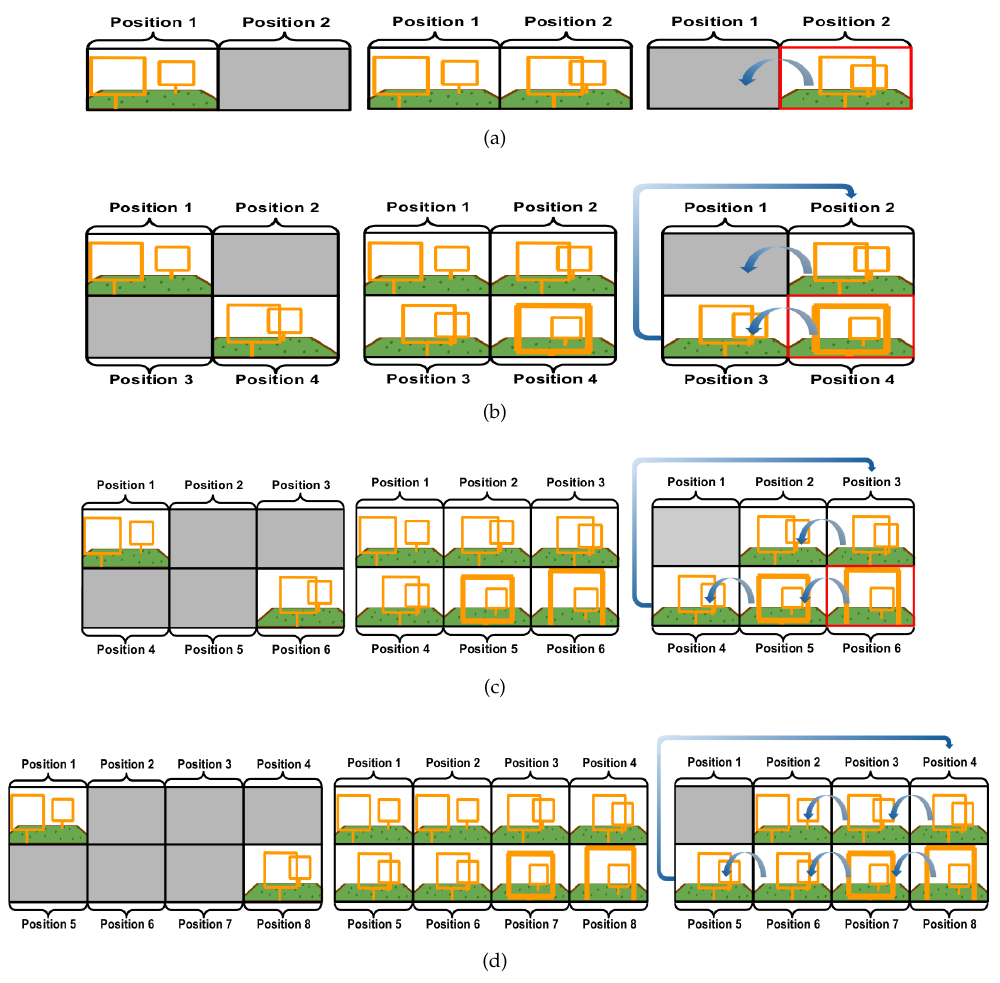
Figure 14. To compose the mosaic, the spaces in the mosaic image are filled every 5 frames: ( a ) Once the mosaic is full, the first frame in the mosaic is removed from position 1, and all frames are shifted to the left, this is, the frame in the position 2 moves to the position 1, and the frame in the position 3 moves to the position 2 and so on. ( b ) Illustrates the process for a mosaic composed of 4 images, note that the image in position 3 moves to position 2 when the shift occurs. ( c , d ) A similar process for when the mosaic is composed of 6 and 8 images,